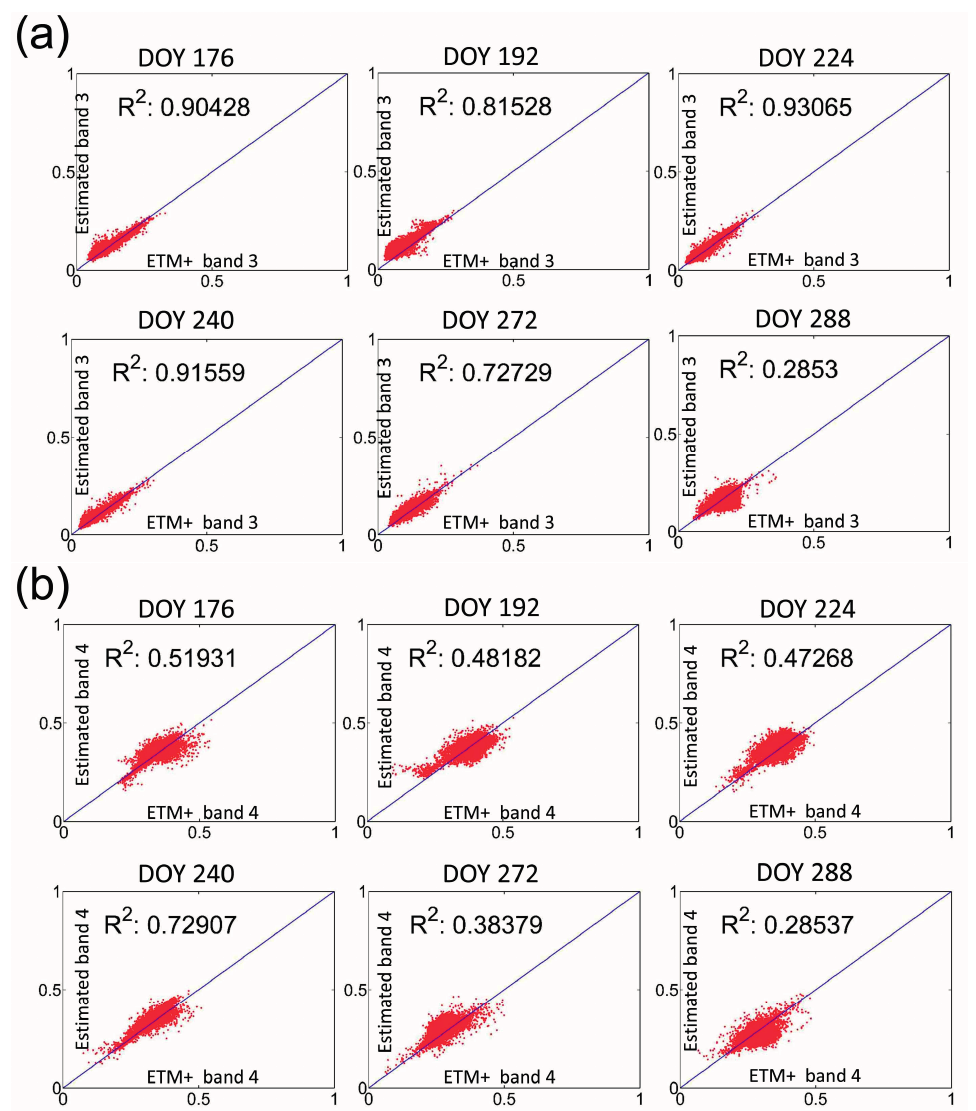
Figure 7. Scatterplots of the blended and the ETM+ data for the 133_33 sub-area. ( a ) scatterplots of the red band; ( b ) scatterplots of the near infrared